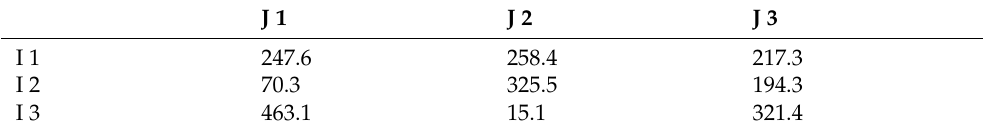
Table A1. Distance between manufacturing plant I and distribution center J (km).